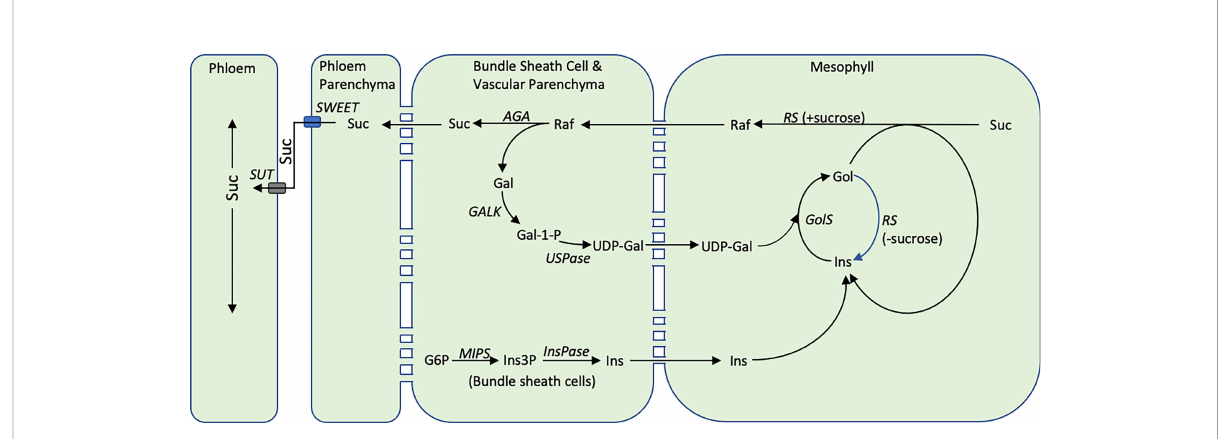
FIGURE 11 The proposed cycle of RFO biosynthesis in sorghum leaves. Some portion of the sucrose synthesized in the mesophyll cells of sorghum leaves is converted into RFOs. Hydrolysis of RFOs by AGA1 in bundle sheath cells creates a concentration gradient moving additional sucrose from mesophyll cells into bundle sheath cells thus helping to regulate the concentration of sucrose in mesophyll cells. Hydrolysis of raf fi nose in bundle sheath cells yields sucrose and galactose. The galactose diffuses back into mesophyll cells for reentry into galactose metabolism. The cellular location of the reactions that convert galactose to UDP-galactose in sorghum are unknown. Inositol synthesis occurs in the bundle sheath cells and inositol potentially diffuses into mesophyll cells where it enters a galactinol metabolic. During the synthesis of RFOs, inositol is released and is recycled. The diagram also shows RS being capable of hydrolyzing galactinol to inositol when sucrose concentration is low, while maintaining its normal function, raf fi nose synthesis, when sucrose concentration is high (Li et al.,